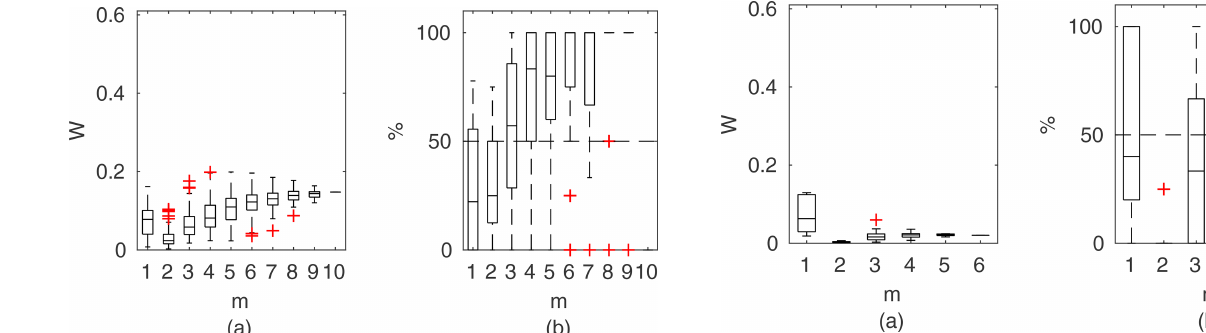
Figure B9. GTLM results for flume case 1: (a) averaged relative confidence widths W as a function of observation set size m used for model identification; (b) percentage of verification points en- closed by the confidence intervals (100% denotes all points within intervals, box spans over the 25% and 75% quantiles, the median is given with horizontal line, whiskers indicate the result extent, and cross marks are for extreme values).